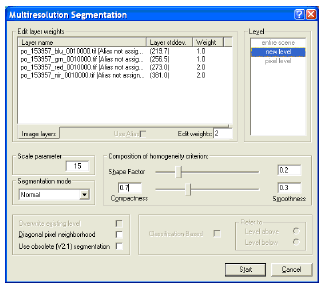
Figure 10. Ikonos, level 1: parameters for the segmentation